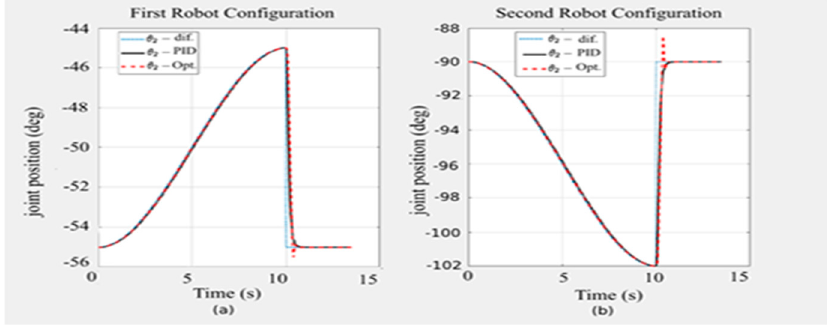
Figure 9. Step response of the UR5 robot for the two configurations of Joint 2.